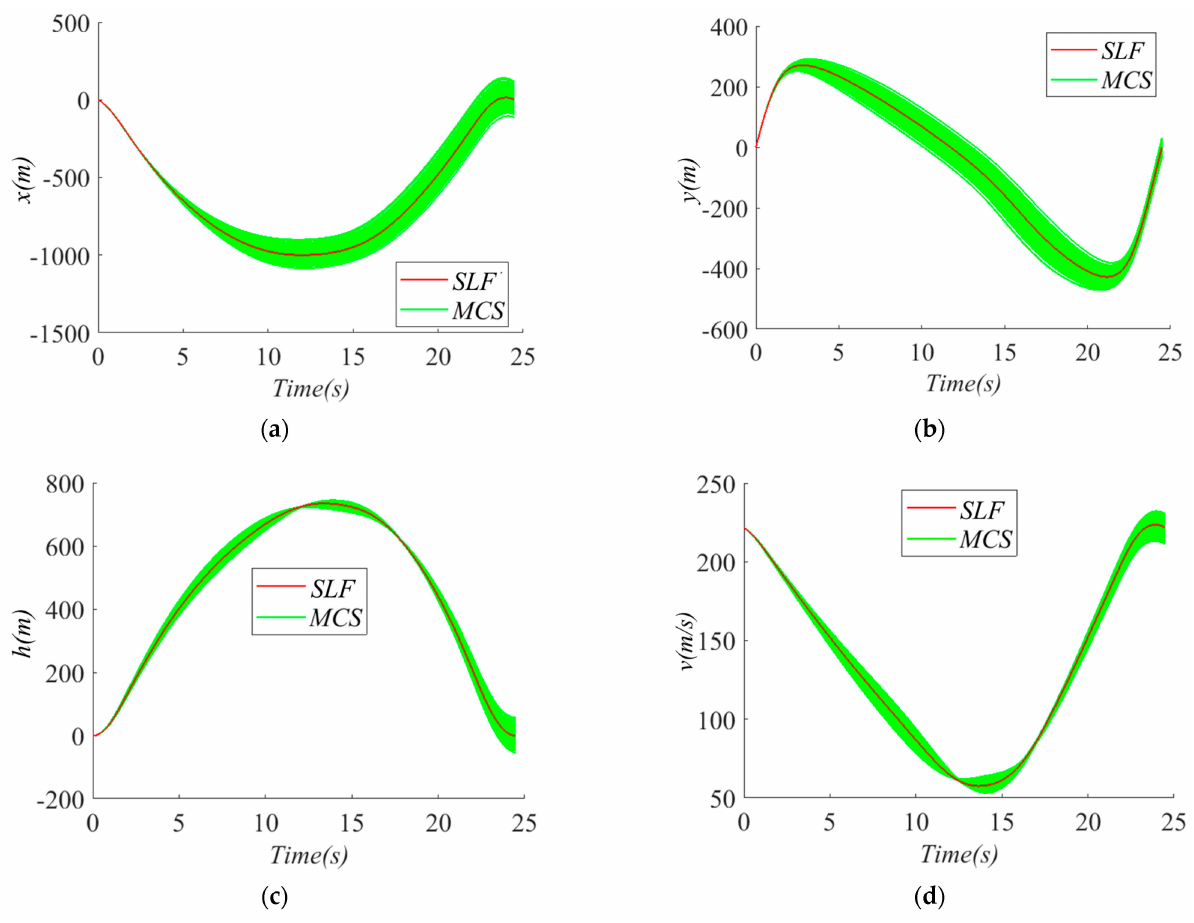
Figure 10. The optimal control curves in RB-CCD optimized by SORA and SLF: ( a ) C L , ( b ) ϕ .